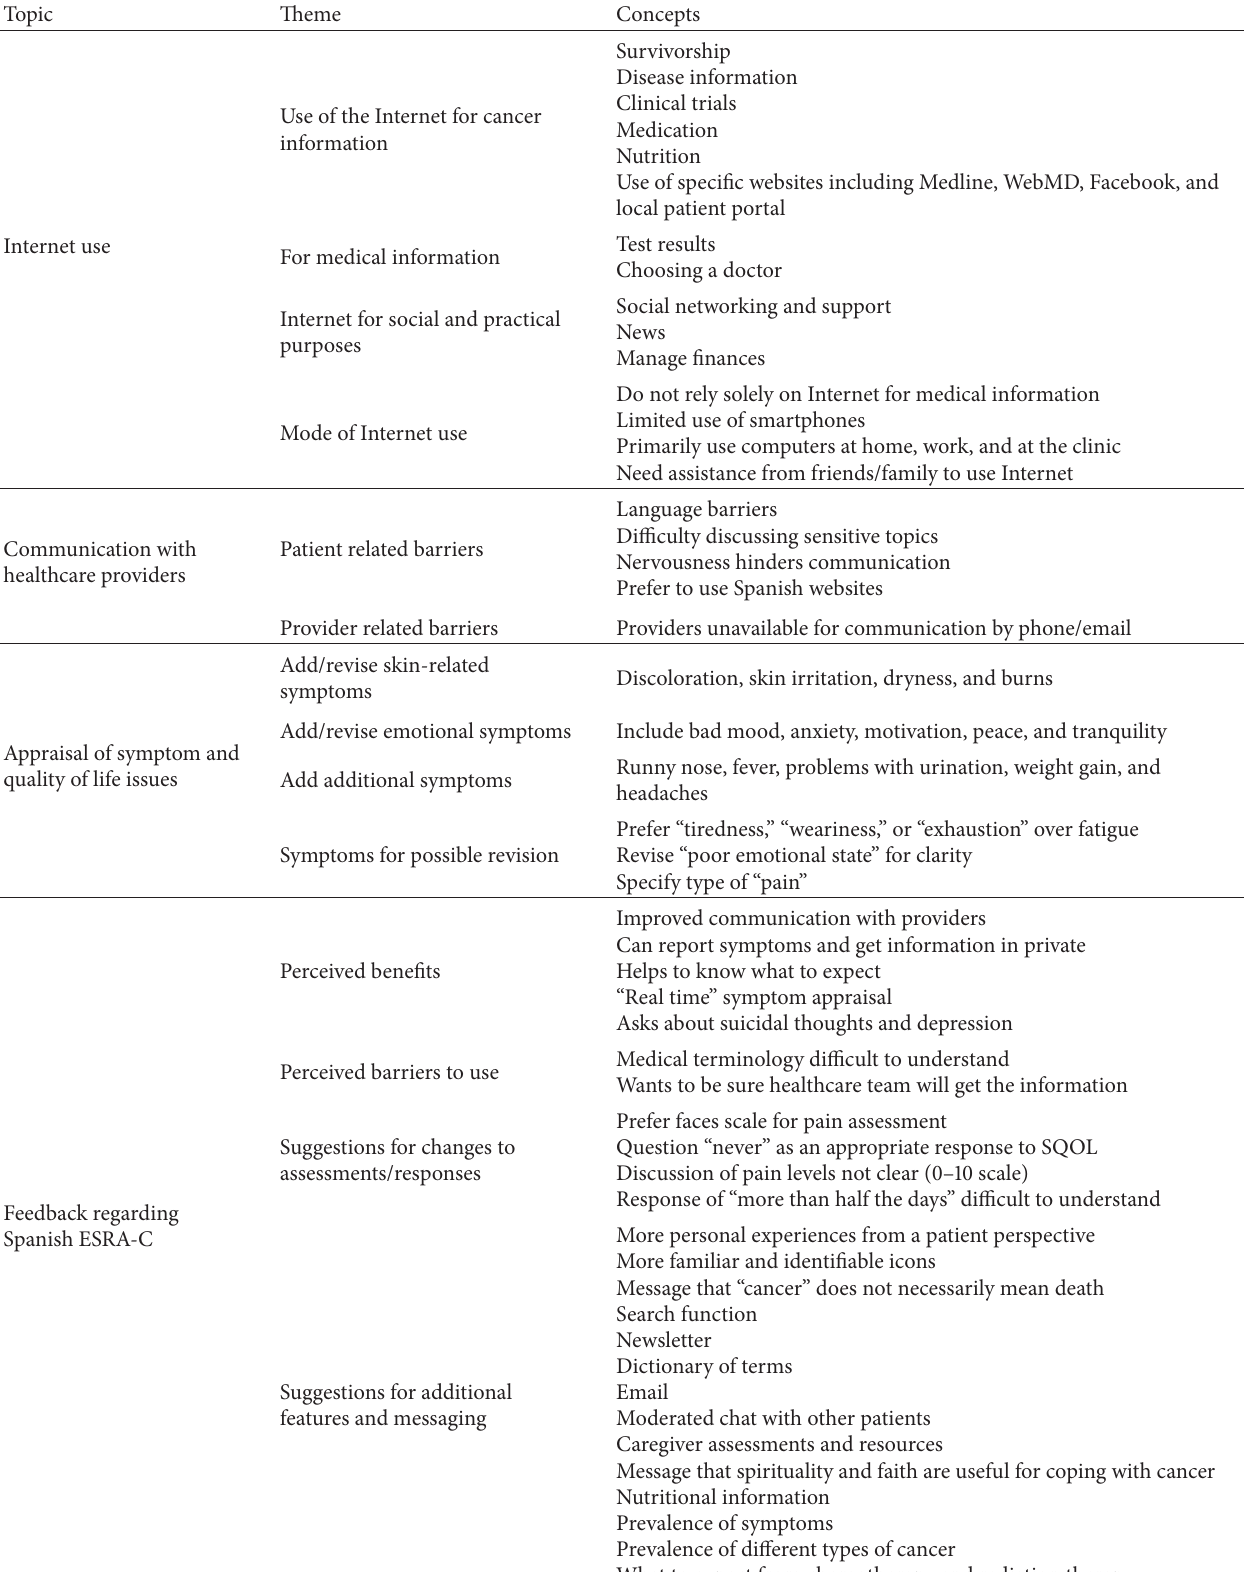
Table 3: Qualitative analysis of focus group transcripts: topics, themes, and